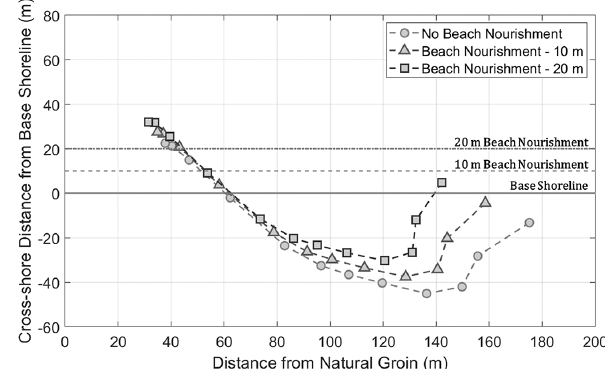
Figure 19. Change in maximum erosion width and indentation in- duced by beach nourishment of two different